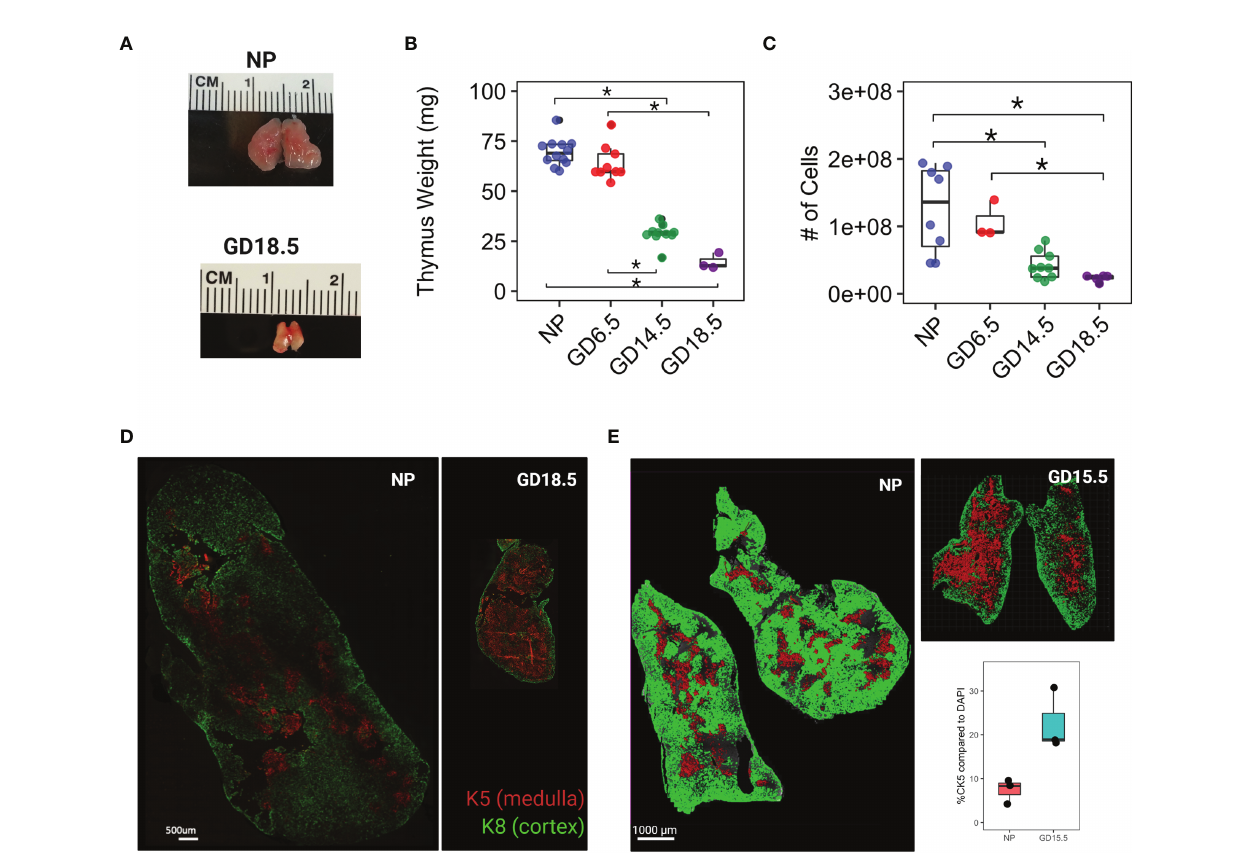
FIGURE 1 | Thymus involution in pregnancy. (A) Comparison of gross anatomy of female murine thymus in non pregnant (NP) and GD18.5. (B) thymus weight throughout pregnancy. (C) Total cell number from thymus throughout pregnancy. (D) Immuno fl uorescence staining of NP and GD18.5 thymus for cytokeratin 5 (K5) and cytokeratin 8 (K8) denoting medulla and cortex, respectively, to illustrate the changes in the volume occupied by each compartment in pregnancy. scale bar = 500 m m. (E) Comparison of area coverage by medulla (red) to DAPI (entire surface area) in NP and GD15.5 thymus using IMARIS surface rendering function. scale bar = 1000 m m. Statistical analysis was performed by non-parametric Kruskal-Wallis test followed by Dunn post hoc test. *p < 0.05, Each dot represents one